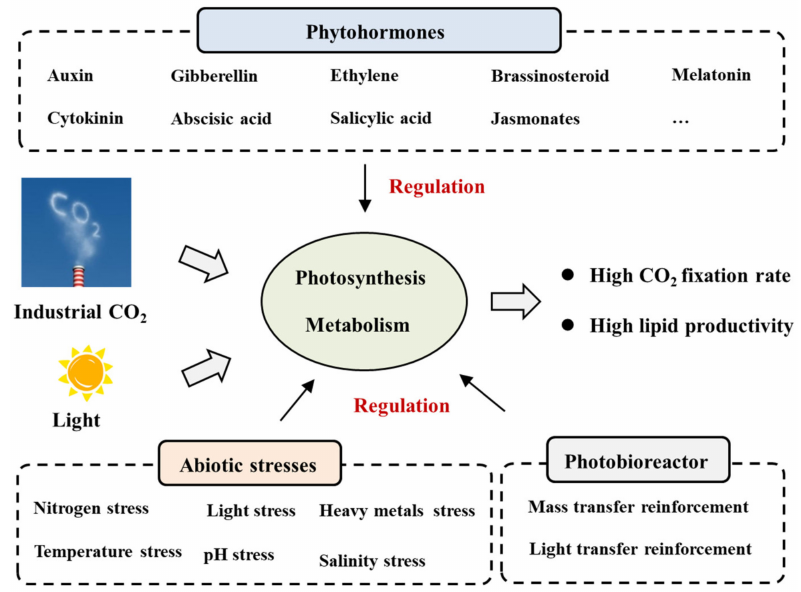
Figure 1. Regulation of CO 2 fixation of microalgae in a photobioreactor by phytohormones and abiotic